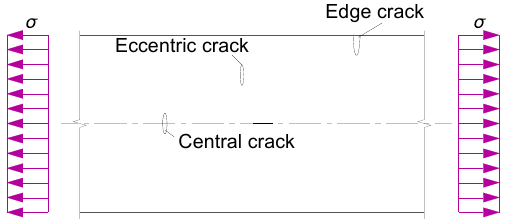
Figure 2. Crack modes in a tension strip.